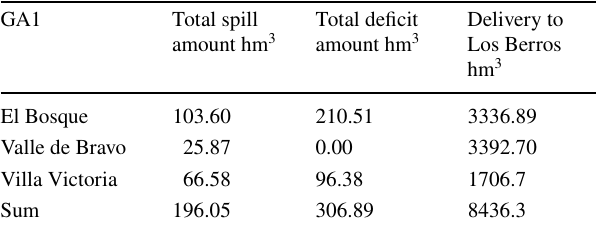
Table 3 Summary of the results of simulating the Cutzamala System from 1999–2018 with genetic algorithm GA1